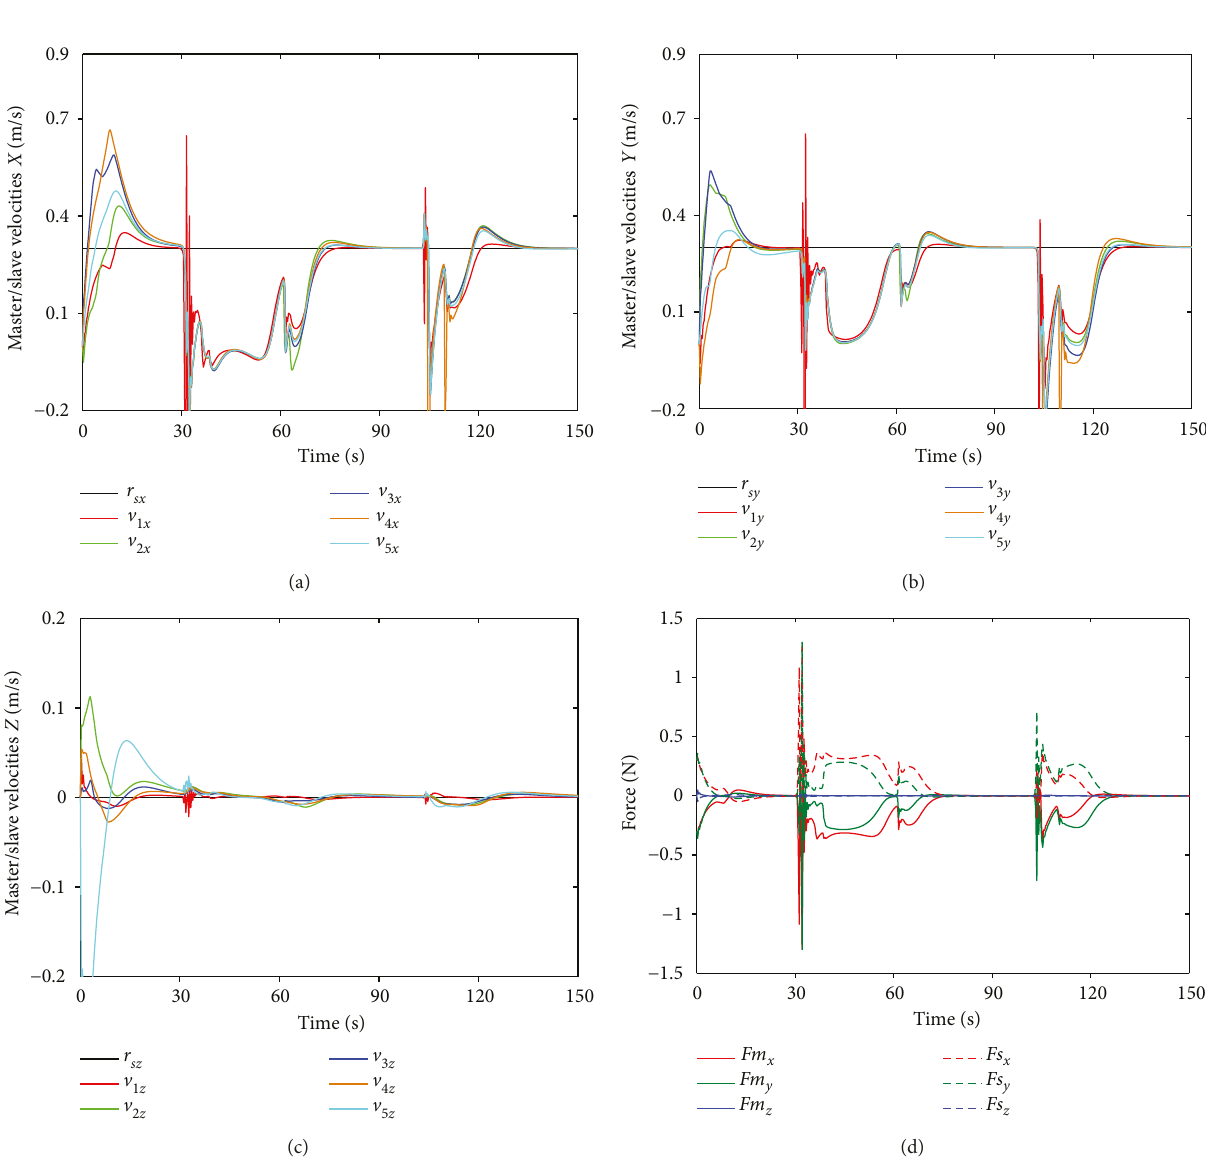
Figure 18: Velocities and force information. (a) The velocities in the x -axis. (b) The velocities in the y -axis. (c) The velocities in the z -axis. (d) The master/slave